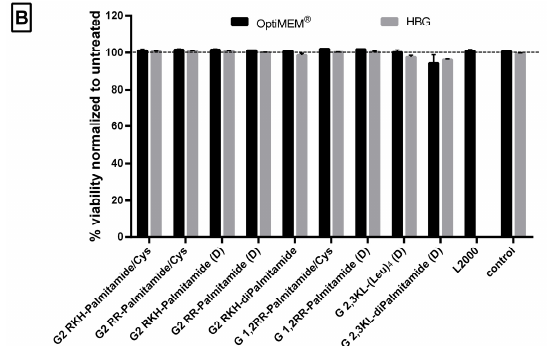
Figure 6. Size measurements of peptide dendrimer/Oligonucleotide complexes and the effect on cell viability. ( A ) Mode of size in (nm) of selected dendrimers. All complexes were formulated in OptiMEM ® , except for G2 RKH-diPalmitamide and G 2,3 KL-diPalmitamide (D) which were formulated in HBG. ( B ) Percent viability of HeLa Luc/705 cells in comparison to untreated cells after transfection with dendrimer/ON complexes in serum-containing media, determined using the WST-1 assay. Values represent the mean with the SEM of at least three experiments performed in triplicate ( n ≥ 3). Mode of size: most prevalent size in a sample. p -values were calculated by one-way ANOVA test and the statistical difference was measured using post hoc Fisher’s LSD test. (ns: non-significant, ** p ≤